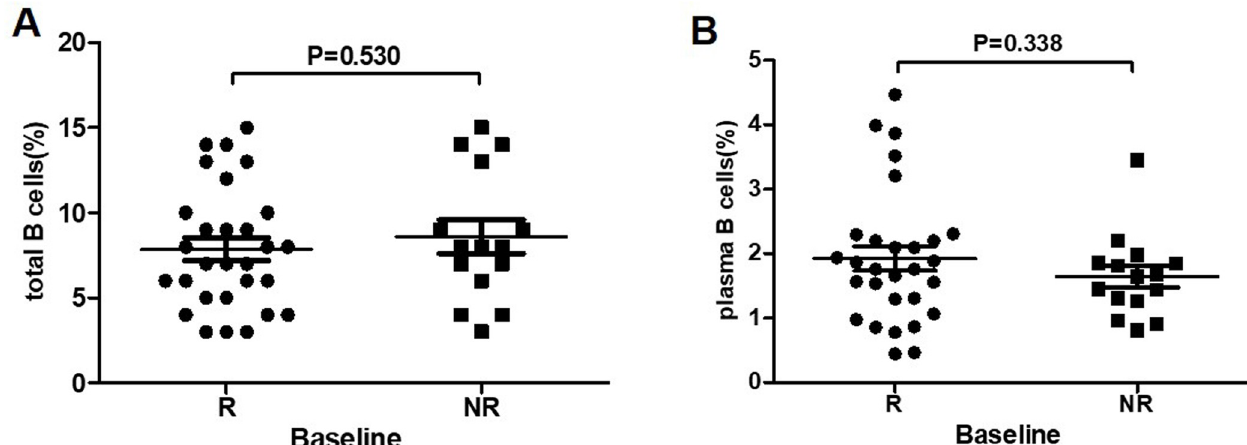
Fig 3. Comparison of total B and plasma B cells between R group and NR group at baseline. (A) Comparison of total B cells between IHCs who achieved HBsAg seroconversion (R group, n = 15) and who failed to achieve HBsAg seroconversion (NR group, n = 29) at baseline. (B) Comparison of plasma B cells between IHCs who achieved HBsAg seroconversion (R group, n = 15) and who failed to achieve HBsAg seroconversion (NR group, n = 29) at baseline.